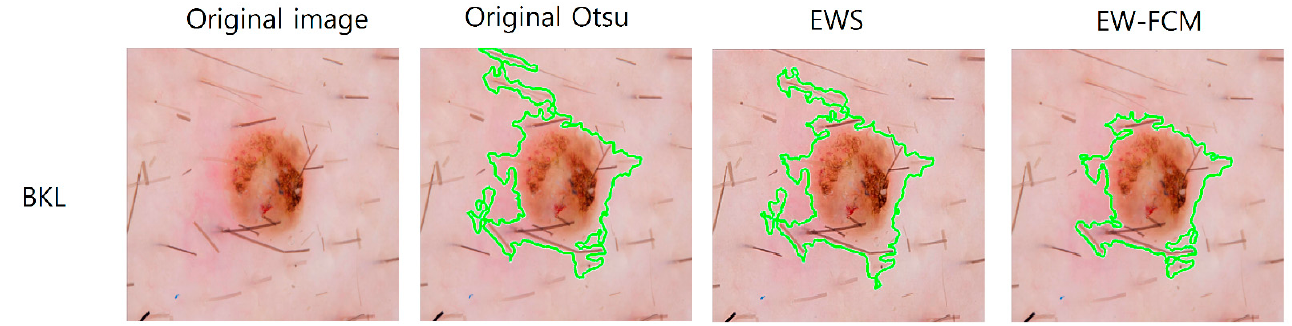
Figure 2. Segmentation results of various methods: Otsu, EWS, and EW-FCM.